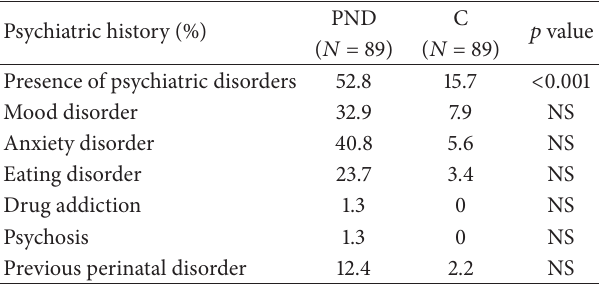
Table 2: Comparison of personal psychiatric history of both groups ( 𝜒 2 ).